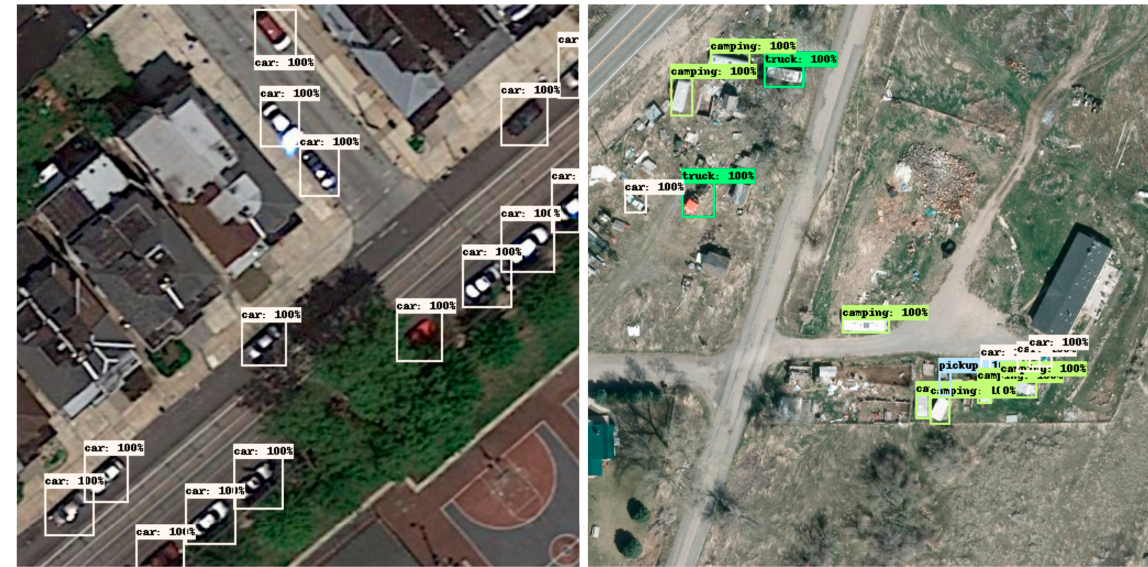
Figure 1. Examples of the vehicles in remote sensing images.